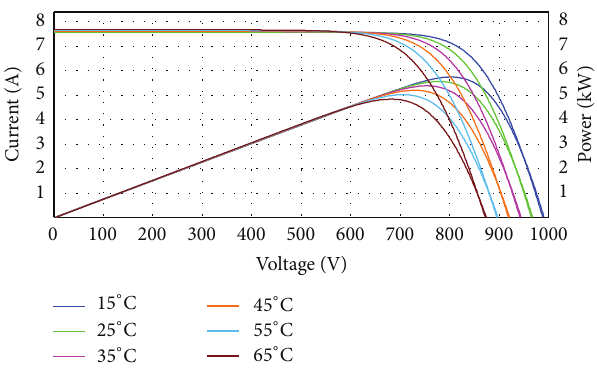
Figure 2: 𝐼 - 𝑉 and 𝑃 - 𝑉 curve with temperature